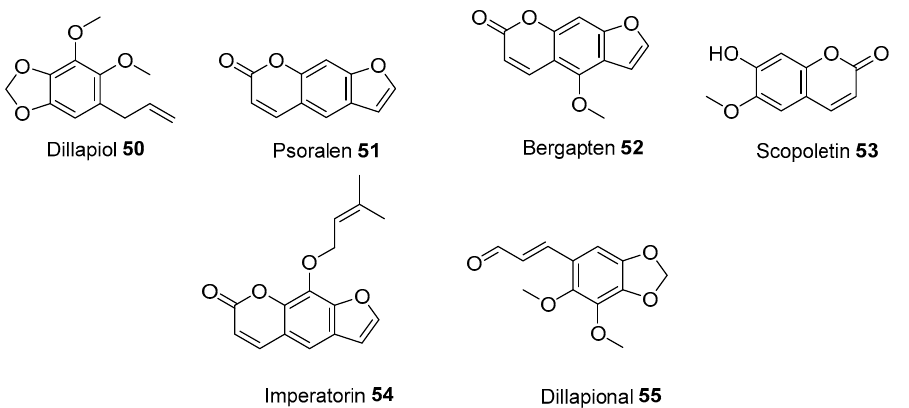
Figure 9. Antimicrobial compounds of plants used by Tenggerese (isolated from same species grown in other countries).